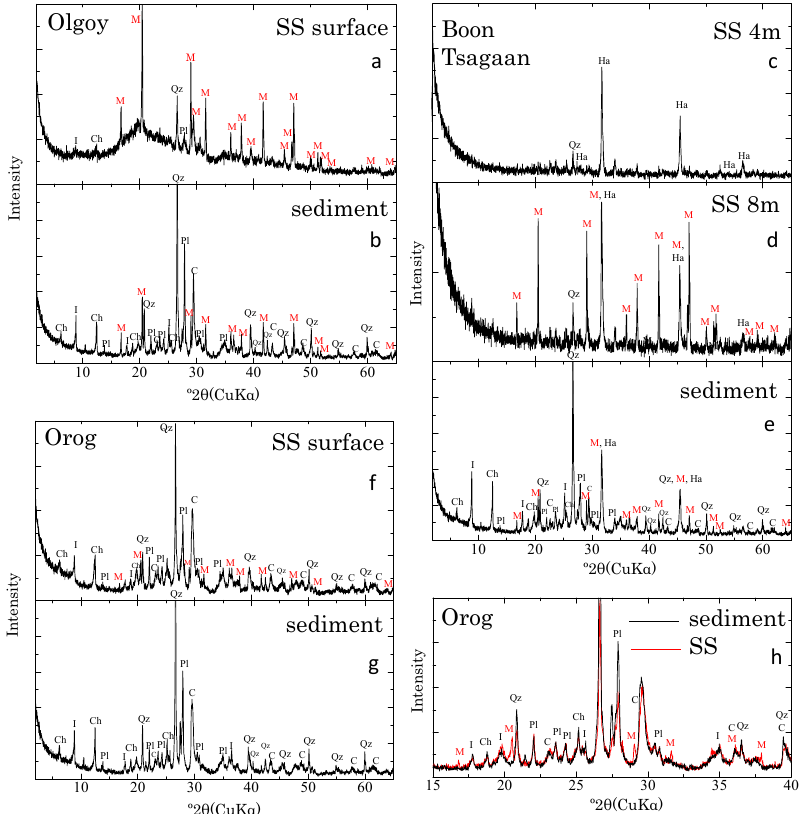
Figure 3. XRD patterns of suspended matter (SS) and benthic sediments from ( a , b ) Olgoy, ( c – e ) Boon Tsagaan, and ( f , g ) Orog Lakes. ( h ) Comparison of XRD patterns of suspended matter (red) and sediment samples (black) from Orog Lake. Mineral abbreviations: M, monohydrocalcite; C, calcite; Qz, quartz; Pl, plagioclase; I, illite; Ch, chlorite; and Ha, halite.